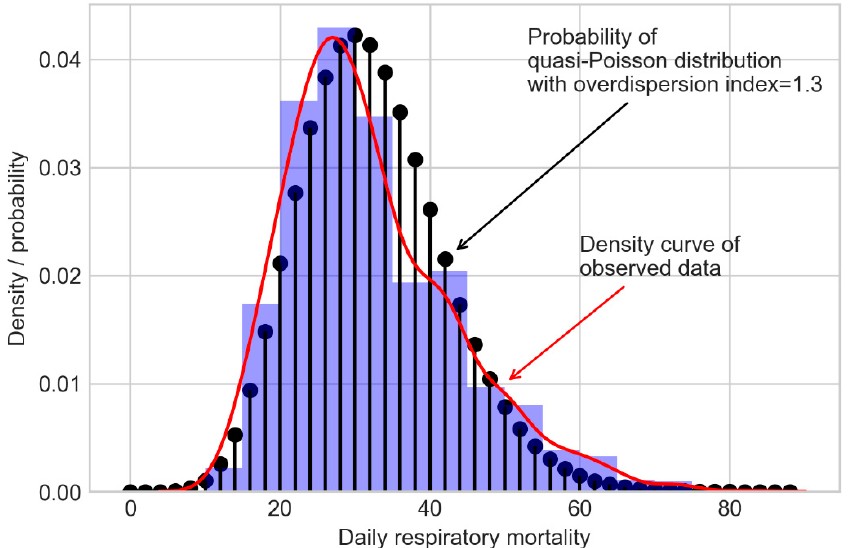
Figure 1. Distribution of observed daily respiratory mortality (the red curve) and theoretical quasi-Poisson distribution (the black vertical lines, mean = 32, overdispersion index = 1.3).